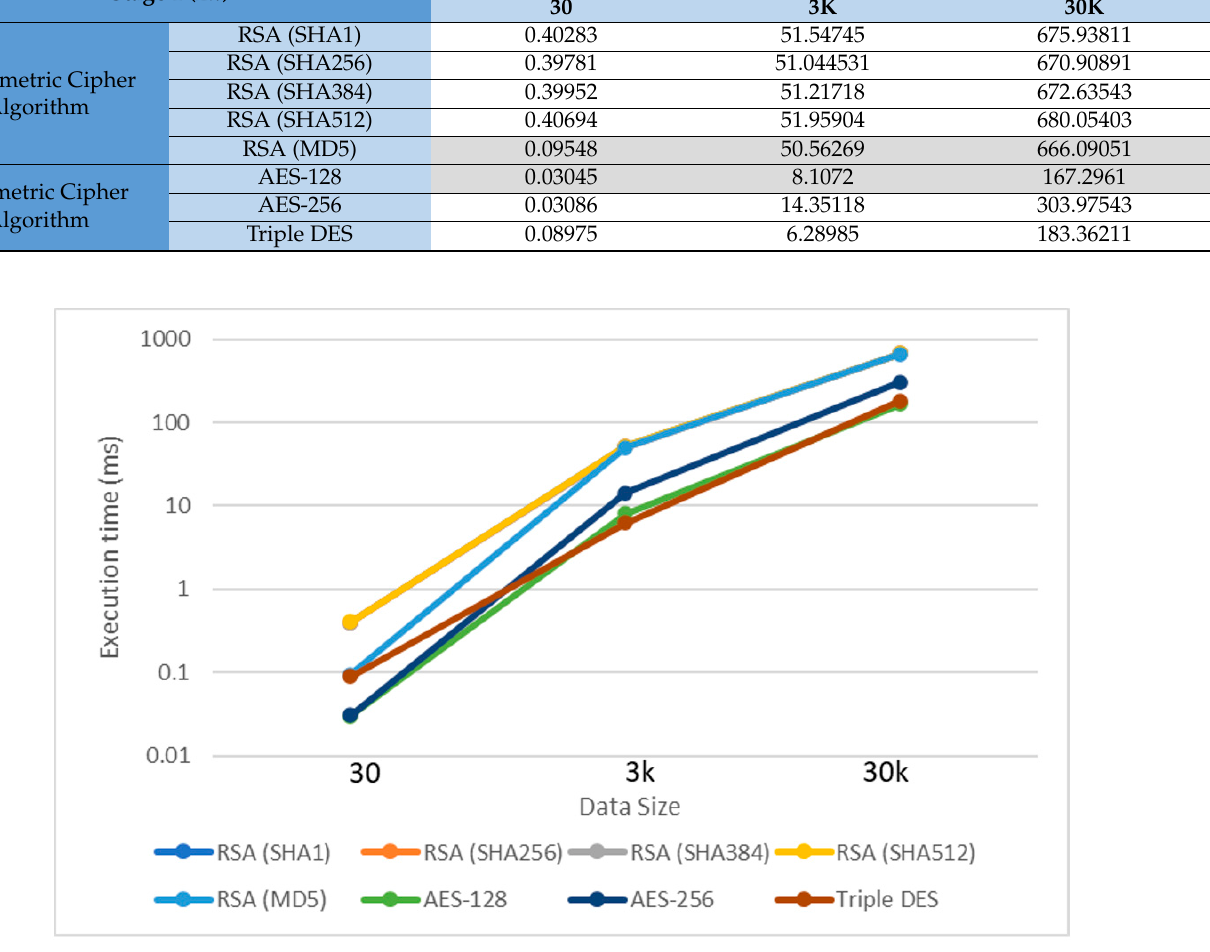
Figure 7. Signature algorithm execution time.